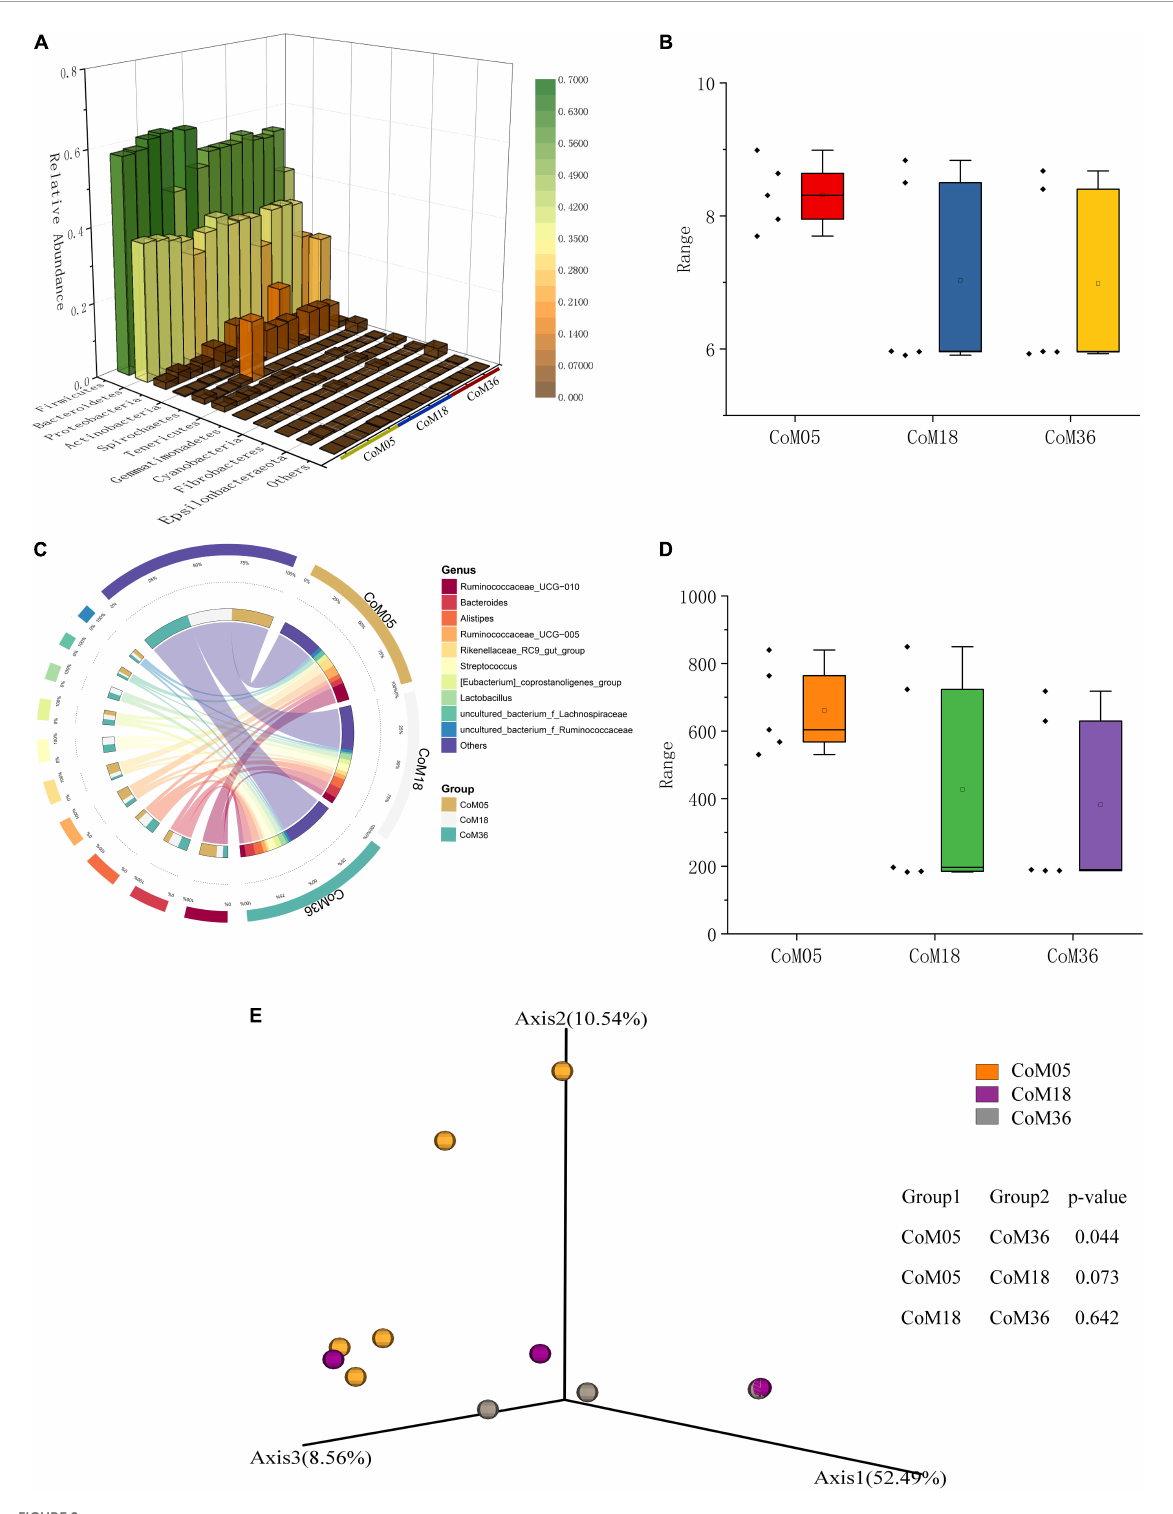
FIGURE2 Relative abundance and diversity of bacterial communities in the colon of post-weaning Mongolian cattle. (A) Taxonomic composition of bacterial phylum, red indicates high relative abundance and green indicates low relative resolution. (B) Shannon index of bacteria in each group. (C) Taxonomic composition of the bacterial genera. Groups are shown on the left side of the large circle, the relative abundance of bacteria is shown on the left side, and the percentage of bacteria in each group is shown on the small circle. (D) Chao1 index of bacteria in each group. (E) Principal co-ordinate analysis of colon bacteria in post-weaning Mongolian